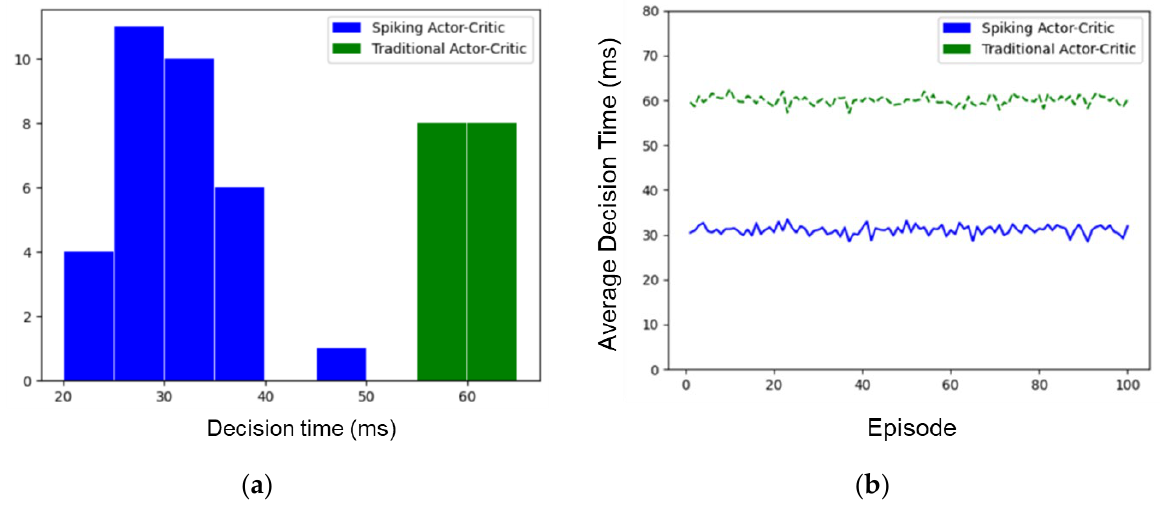
Figure 16. Comparison with the traditional AC network: ( a ) The distribution of decision times for one of the basketball avoidances; ( b ) The average decision time for one hundred basketball avoidance experiments.